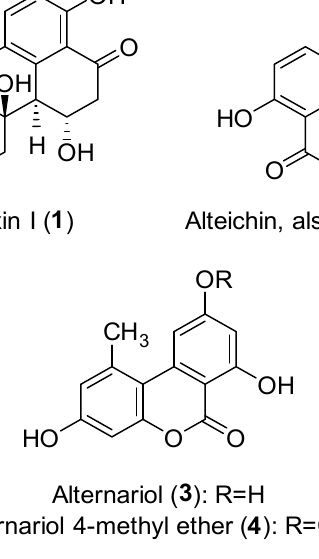
Figure 4. Chemical structure of the isolated